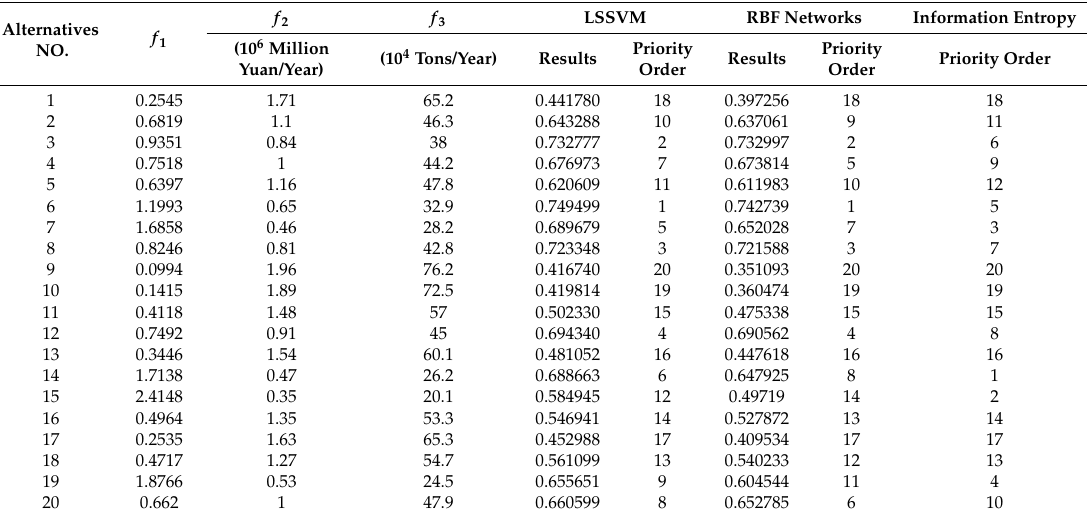
Table 4. The ranking results of representative alternatives based on LSSVM, RBF networks and information entropy. Alternatives